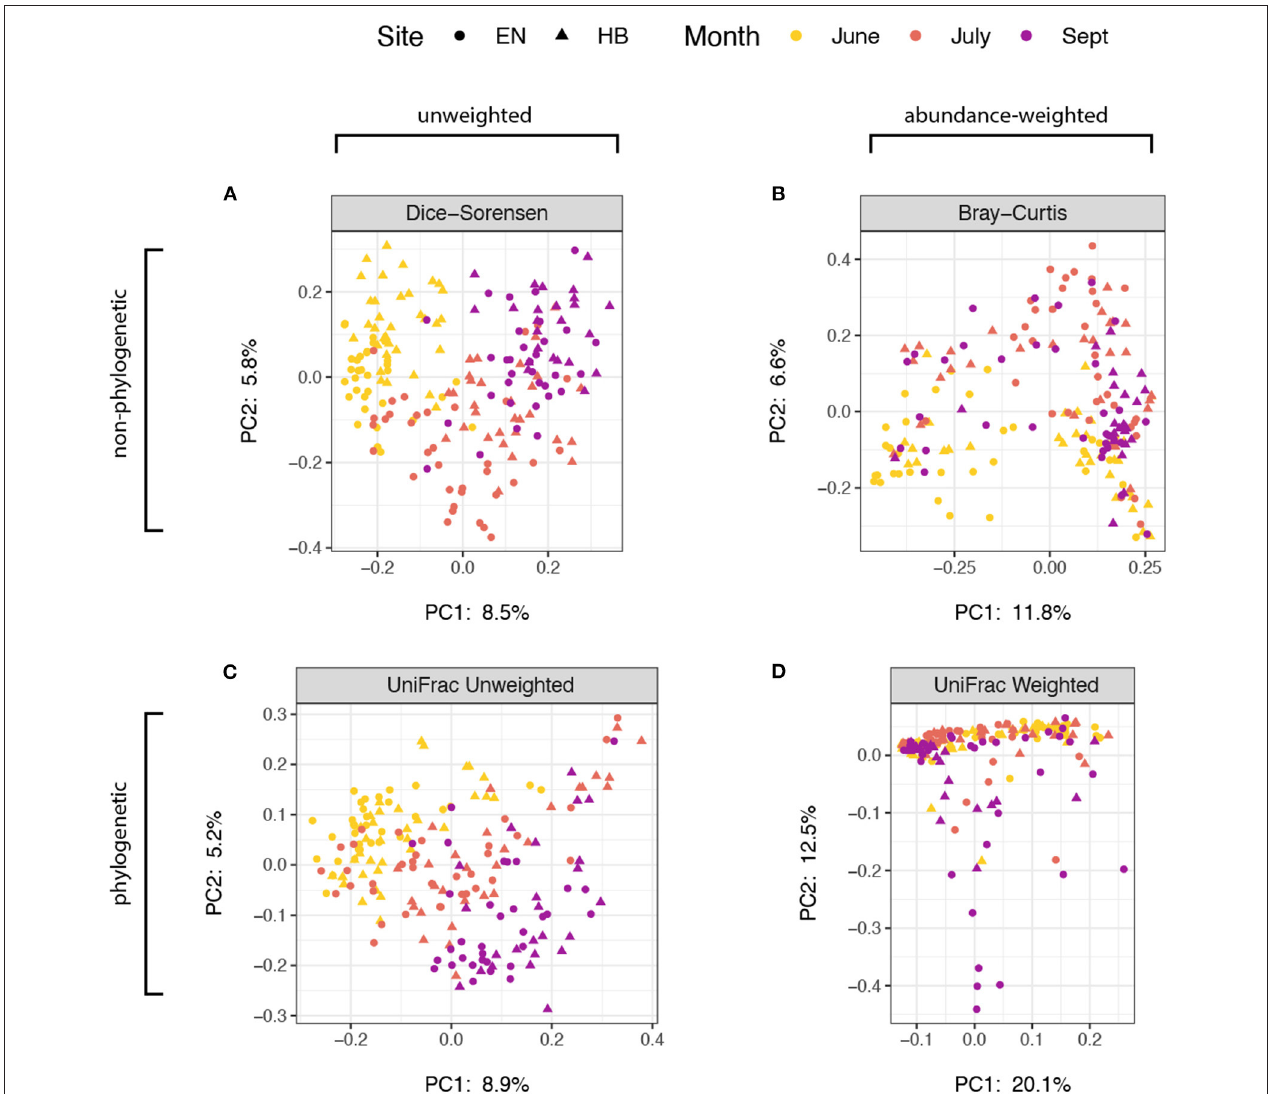
FIGURE 3 | Principal coordinates analysis of distance estimate ordinated with samples distinguished by sampling site as points (Egner, “EN”; Hickory Bottoms, “HB”) and sampling month as colors. The four distance metrics varied with respect to sequence abundance and phylogenetic weights: (A) Dice-Sorensen, unweighted abundance and unweighted phylogenetic; (B) Bray-Curtis, weighted-abundance and unweighted phylogenetic; (C) UniFrac Unweighted, unweighted abundance, weighted phylogenetic; (D) UniFrac Weighted, weighted abundance and weighted phylogenetic. The proportion of variance captured by each of the first two principal component axes are